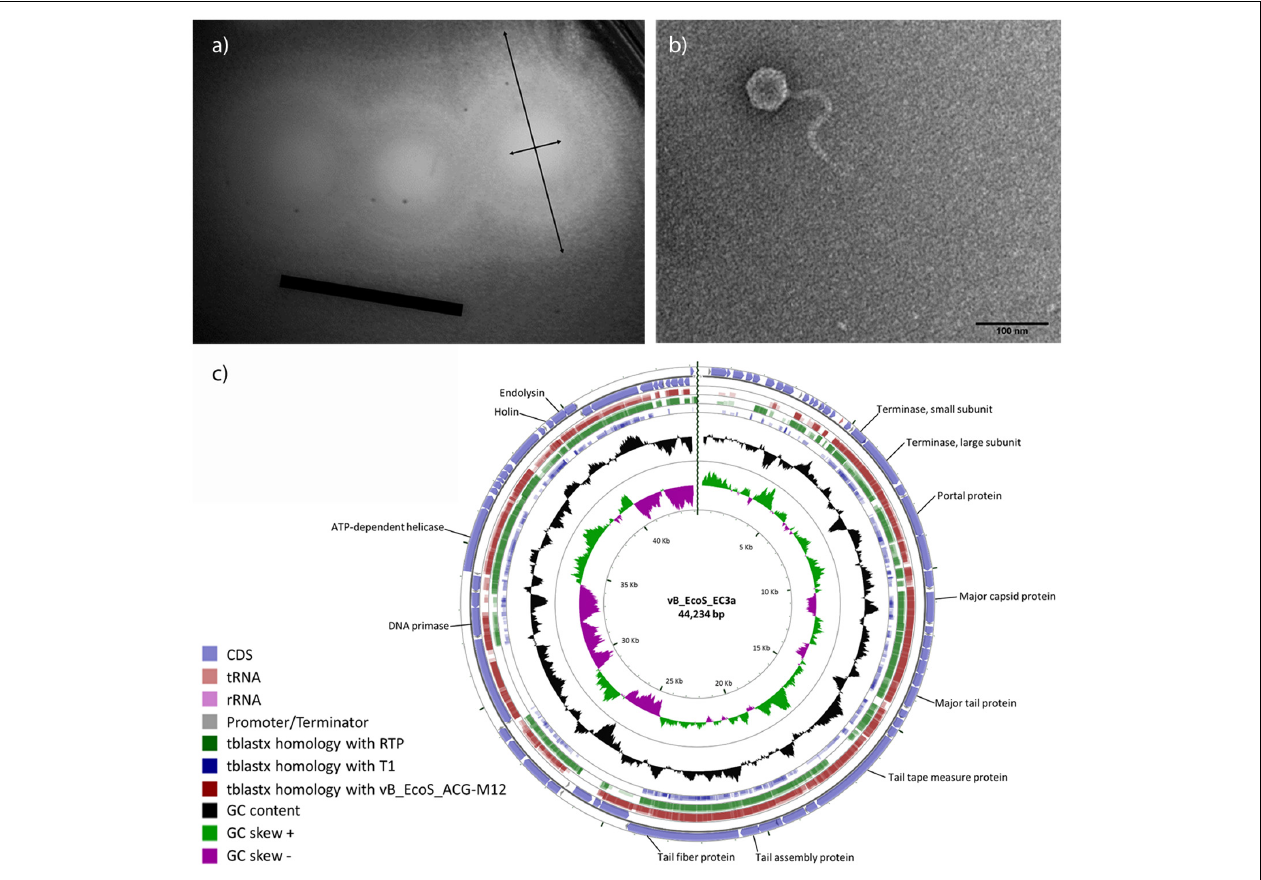
FIGURE 1 | Characteristics of EC3a. (a) Plaque morphology (black arrows indicate diameter of EC3a plaque and diameter of EC3a plaque and the surrounding halo. Scale bar 1 cm), (b) virion particle, and (c) circular view of phage vB_EcoS_CEB-EC3a and TBLASTX comparison with the two closest E. coli phage homologs and T1. The outer ring represents EC3a CDSs. The other three outer rings represent TBLASTX homologies with phages M12, RTP, and T1, respectively. The GC content appears in the black ring, and the inner rings are the GC skew + (green) and the GC skew − (pink). Some important EC3a genes are